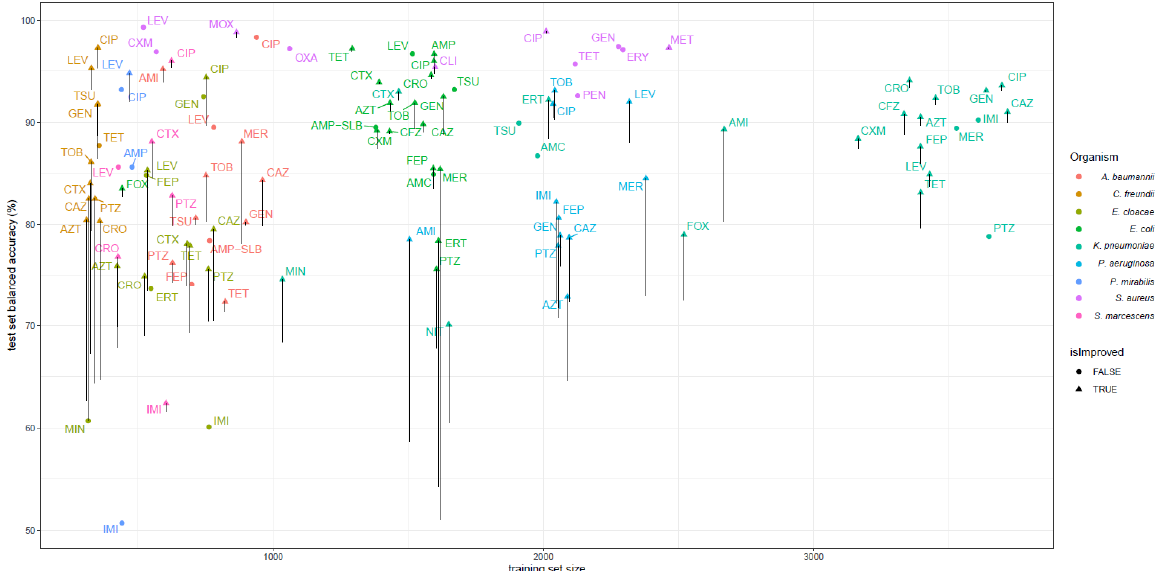
Figure 2. Balanced accuracy of 110 models evaluated on the 20% test set splits. The training set size is shown on the x -axis. For each dataset, the balanced accuracy of the best performing model of the three models considered, trained on different feature spaces (DNA k-mers, extended dataset, extended + PROVEAN features), is shown. Vertical lines indicate the increase in balanced accuracy on individual datasets from the original feature space. Section 4.2 lists all compound names and their abbreviations as shown here. A small scatter is added on the x-axis to avoid overlapping vertical